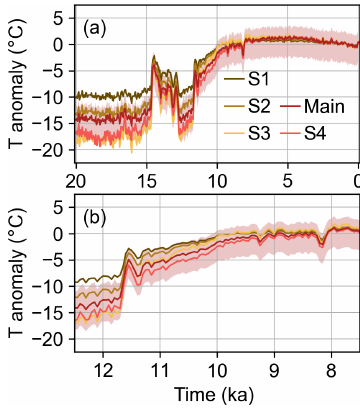
Figure 9. The main temperature ( T ) reanalysis (ensemble mean and 5th to 95th percentile shading) and ensemble mean for four sensitivity scenarios: S1–S4. Panel (a) shows the full 20000-year reconstruction, while panel (b) shows a the Younger Dryas to early Holocene period (13 to 7ka). Each sensitivity scenario reflects a different assumption about precipitation seasonality, with S1– S3 assuming a spatially uniform seasonality and S3–S4 assuming stronger seasonality than the main reanalysis. Anomalies are with respect to the mean of 1850–2000 CE. These time series are for the location closest to Summit, which is representative of the results around Greenland.